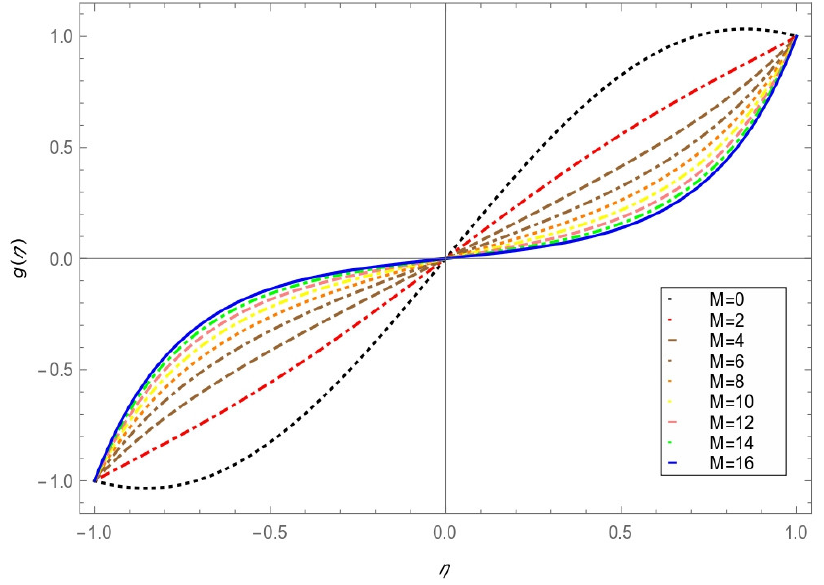
Figure 12. Impact of M on the tangential velocity profile for α = 1, Re = 1, ϕ 1 = ϕ 2 = 0.01, Pr = 6.2 .